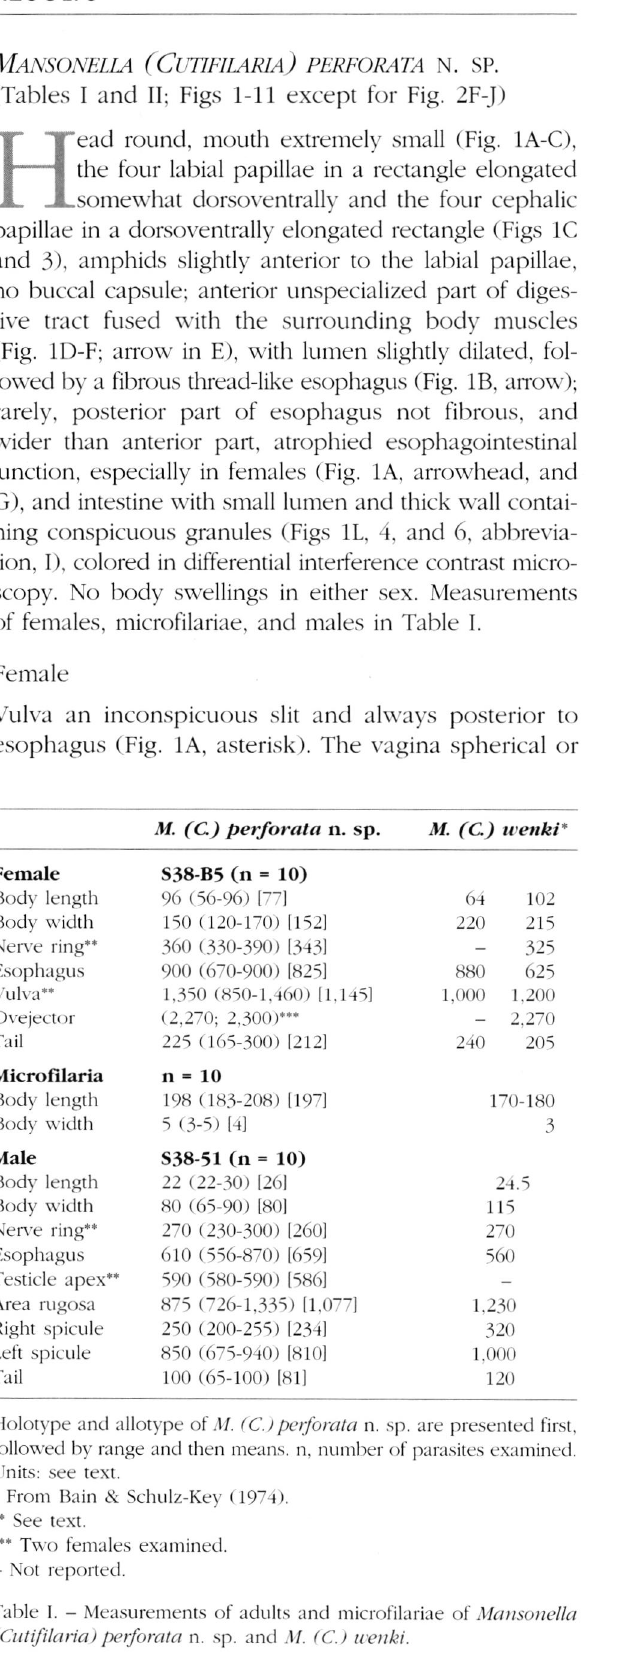
Table I. - Measurements of adults and microfilariae of Mansonella (Cutifilaria) perforata n. sp. and .M.